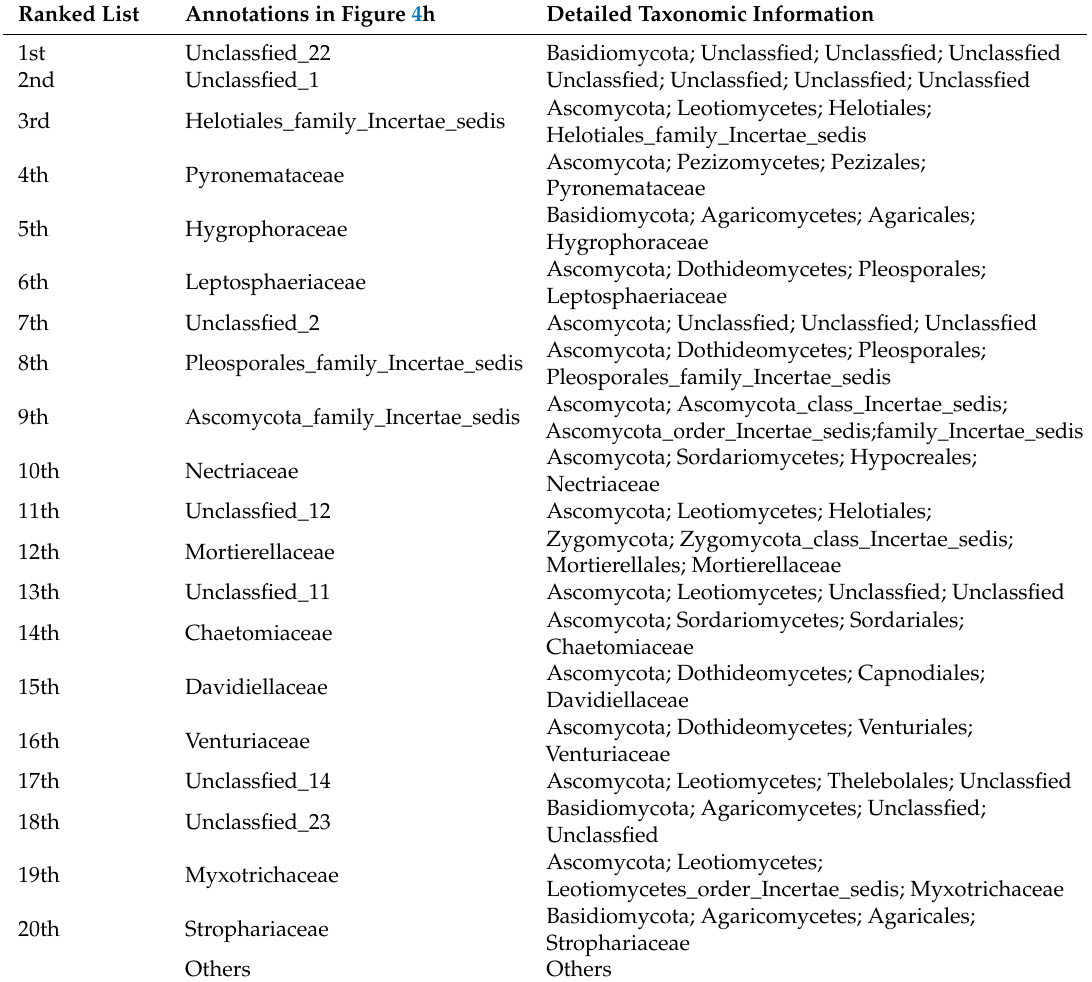
Table A5. The detailed taxonomic information of the top 20 fungi of soil samples on family rank. Ranked